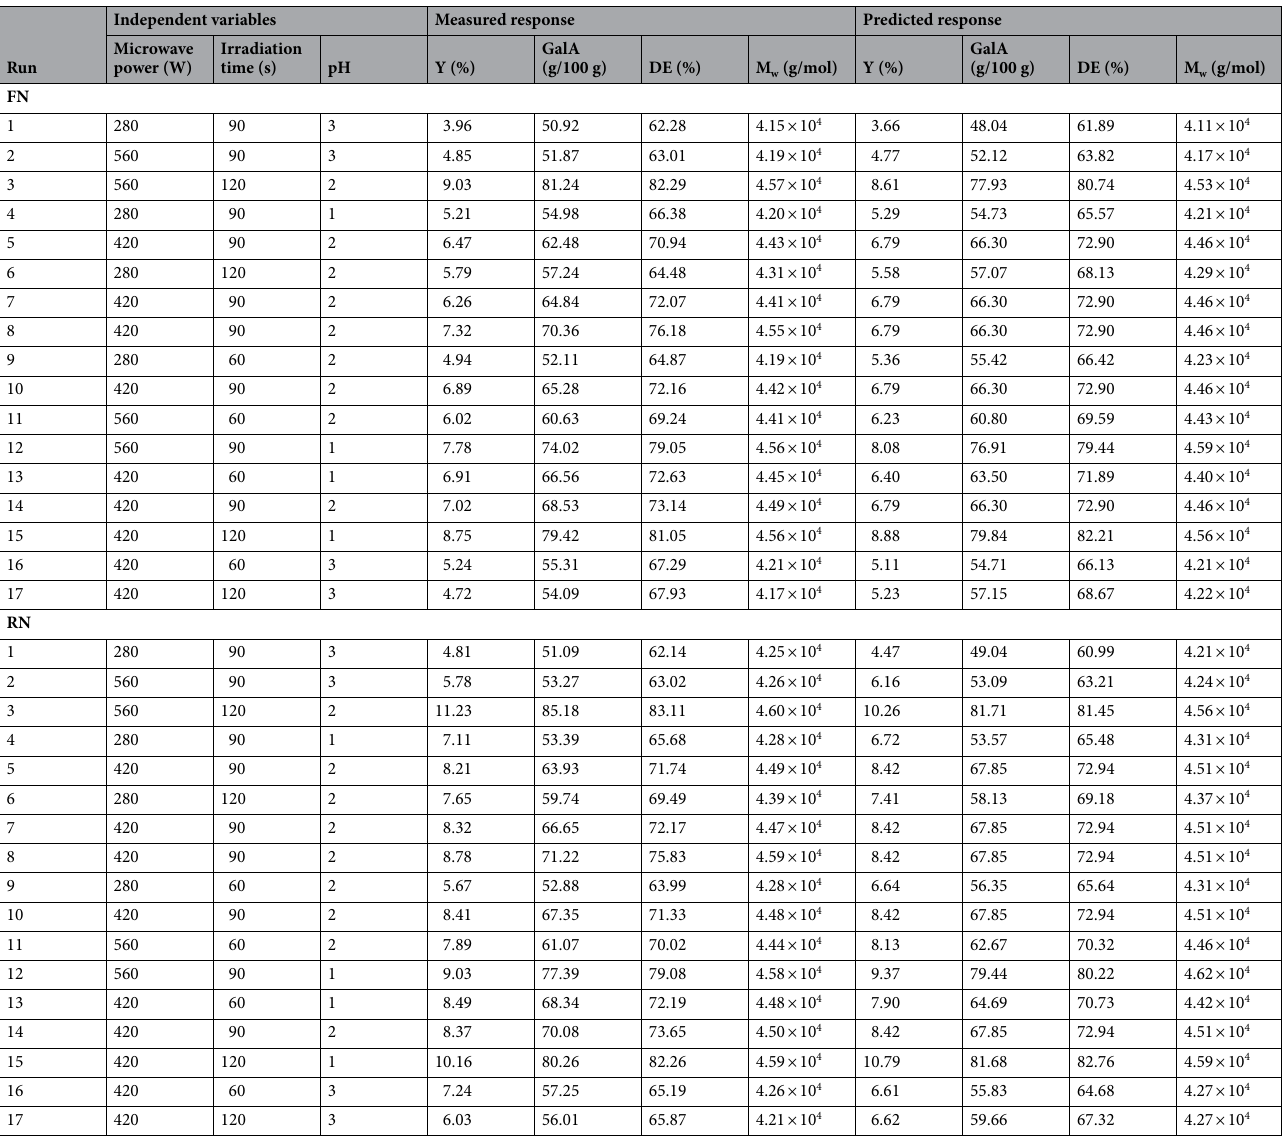
Table 2. Box–Behnken experimental design matrix with measured and predicted values. FN Fetească Neagră, RN Rară Neagră, Y yield, GalA galacturonic acid content, DE degree of esterification, M w molecular